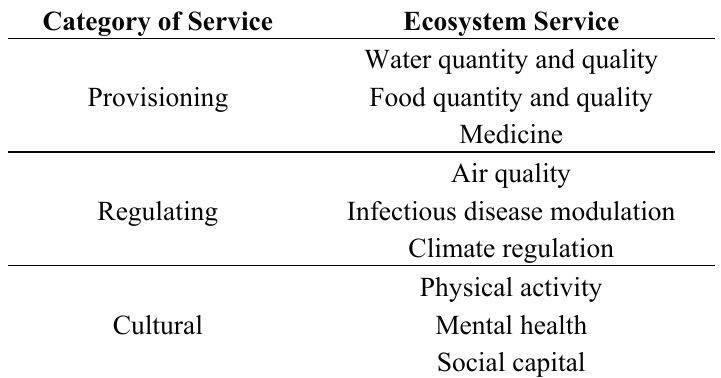
Table 1. Categorization of ecosystem services supported by green